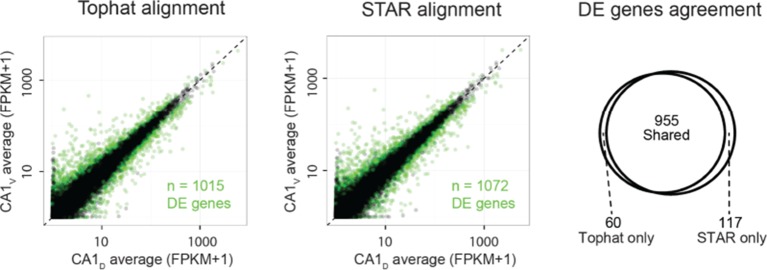
DOI:
http://dx.doi.org/10.7554/eLife.14997.022